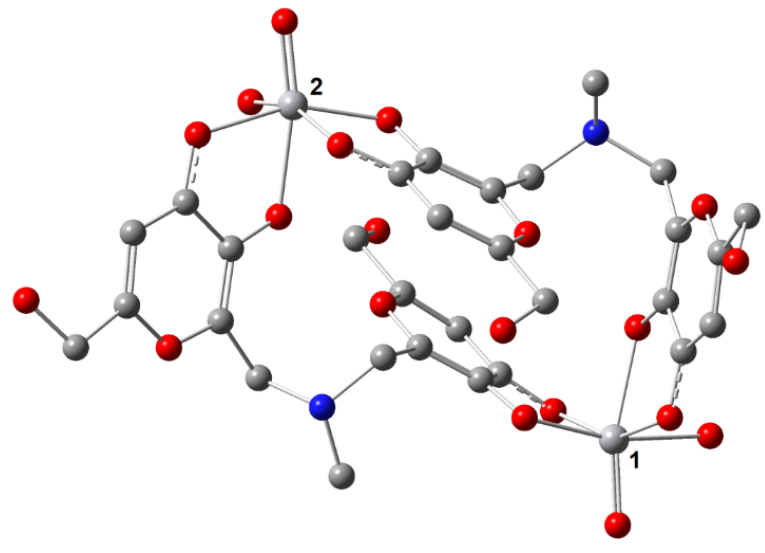
Figure 10. DFT optimized structure of [(V IV O) 2 (L4) 2 (H 2 O) 2 ]. The V · · · V distance is 8.88 Å. The two V IV O 2+ centers are indicated with 1 and 2 . The hydrogen atoms are omitted for clarity. In addition, the A z ( 51 V) values of the two V IV O 2+ centers were calculated by the DFT protocol established in the literature, which allows to predict them with a mean absolute percent deviation (MAPD) from the experimental values below 4% and a standard deviation (SD) around 3% [54]. The results are listed in Table 4; the PD values for A z are below 1%, in line with the previous results